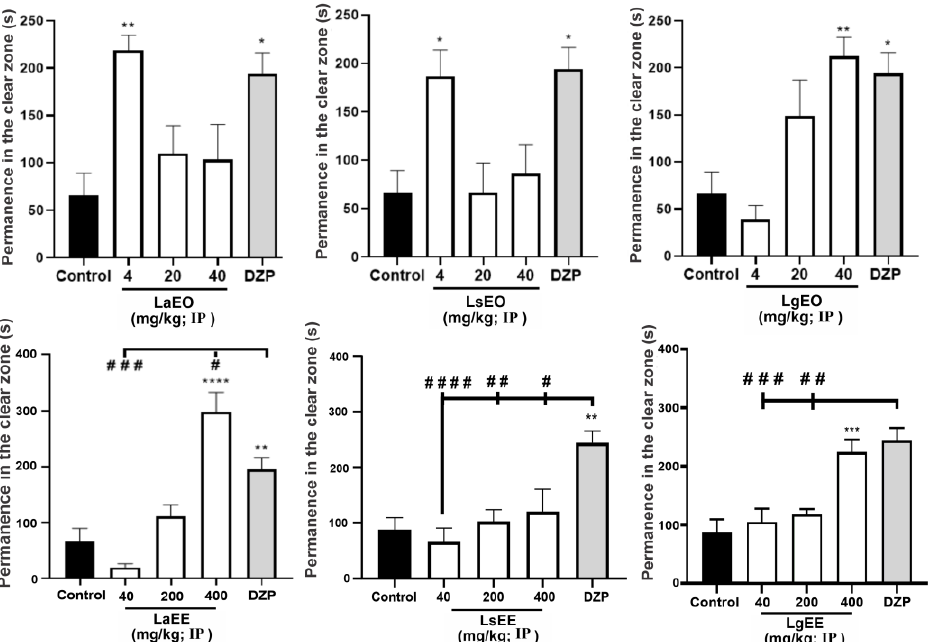
Figure 5. The anxiolytic effect of essential oils and ethanolic extracts of L. alba , L. sidoides , and L. gracilis in the light/dark test (0 – 5 min). The values represent the mean ± standard error of mean of six animals/group; ANOVA followed by Tukey’s test (* p < 0.05, ** p < 0.01, *** p < 0.001, **** p < 0.0001, vs. control; # p < 0.05, ## p < 0.01, ### p < 0.001, #### p < 0.0001 vs. DZP). LaEO: Lippia alba essential oil; LsEO: Lippia sidoides essential oil; LgEO: Lippia gracilis essential oil; LaEE: Lippia alba ethanolic extract; LsEE: Lippia sidoides ethanolic extract; LgEE: Lippia gracilis ethanolic extract; DZP: diazepam.